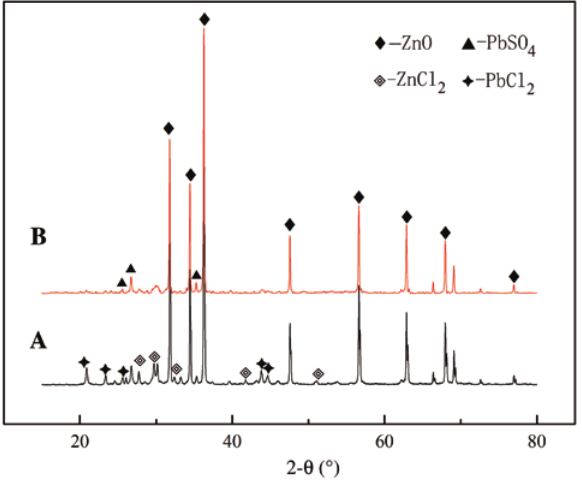
Figure 9: X-ray diffraction (XRD) patterns of zinc oxide dust before and after microwave roasting. (A) raw material, (B) the sample of roasting temperature at 650 °